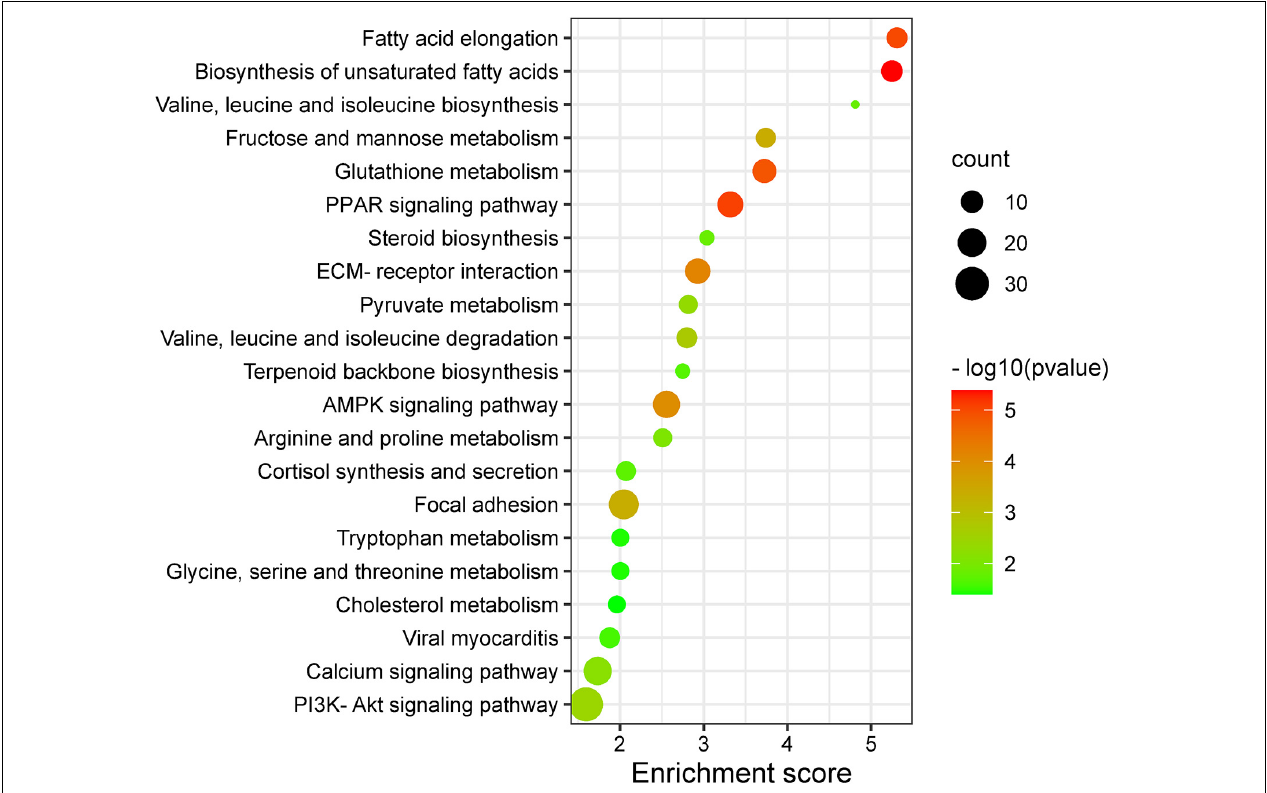
FIGURE 1 | Important Kyoto Encyclopedia of Genes and Genomes (KEGG) pathway terms ( p < 0.05) enriched by differentially expressed genes (DEGs) in subcutaneous fat of female (FYs) and male yaks (MYs). The X -axis means rich factor. The Y -axis represents the KEGG pathway terms. The roundness color represents the p value. The roundness area represents the DEG number in this